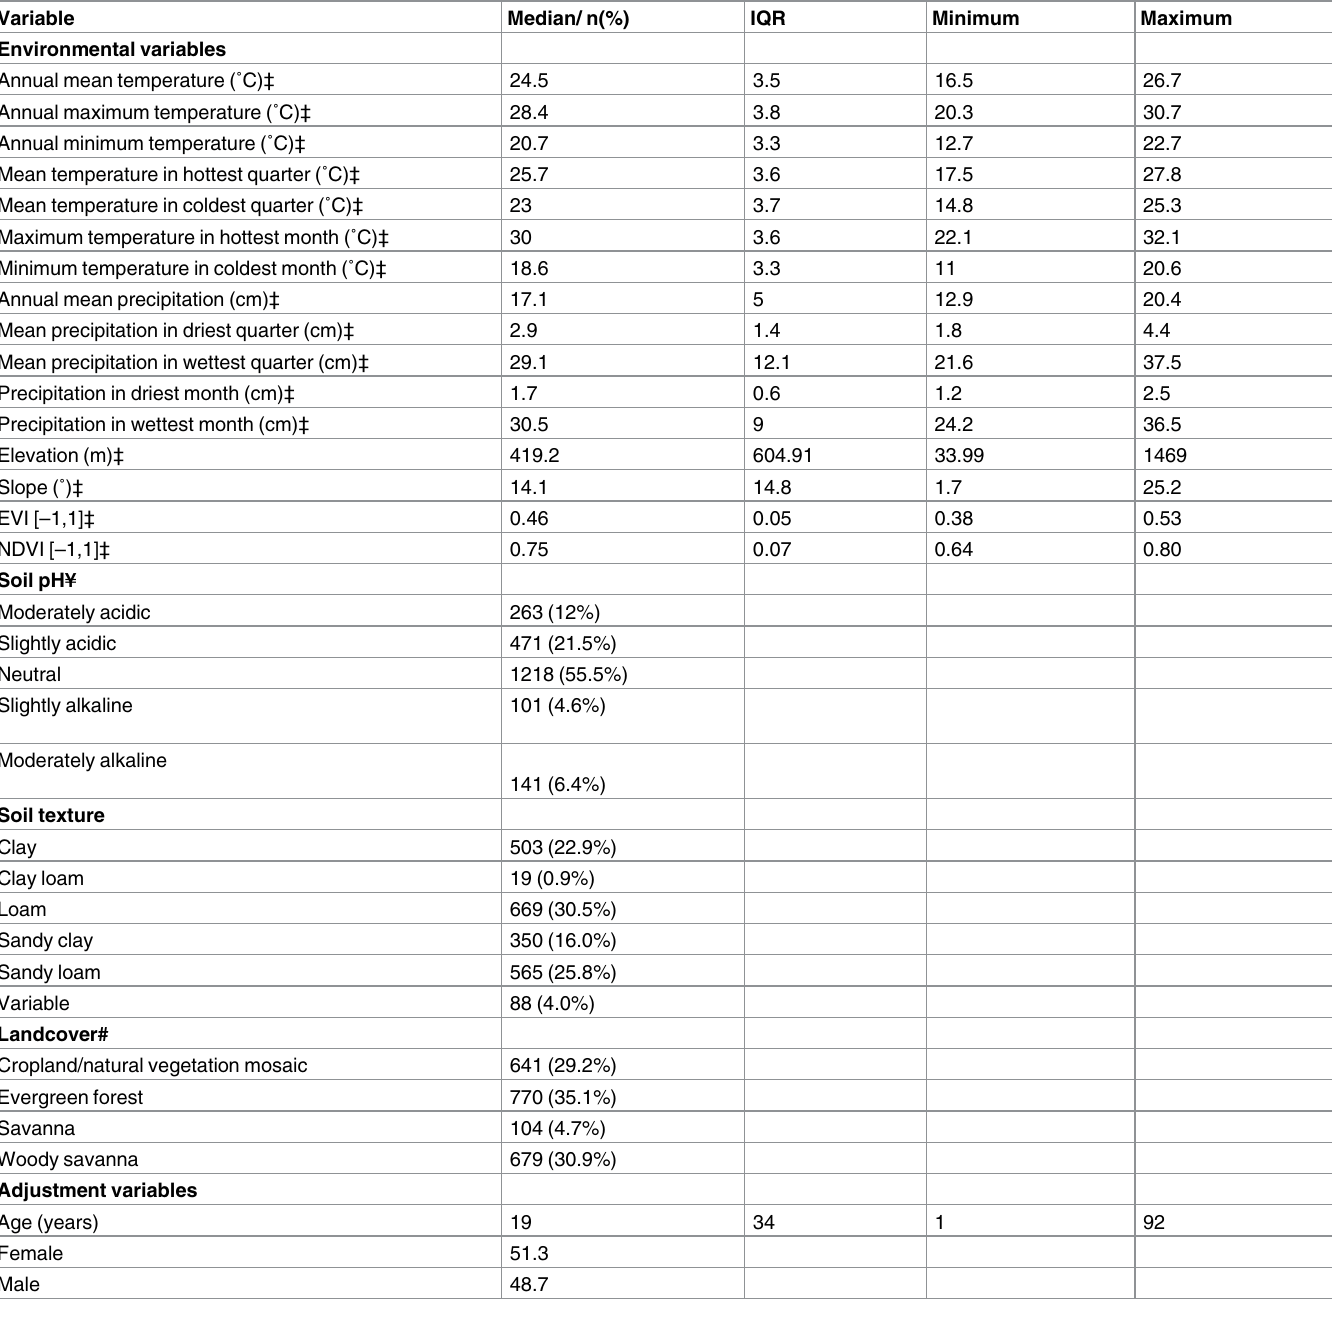
Table 2. Characteristics of environmental conditions surrounding study participants’